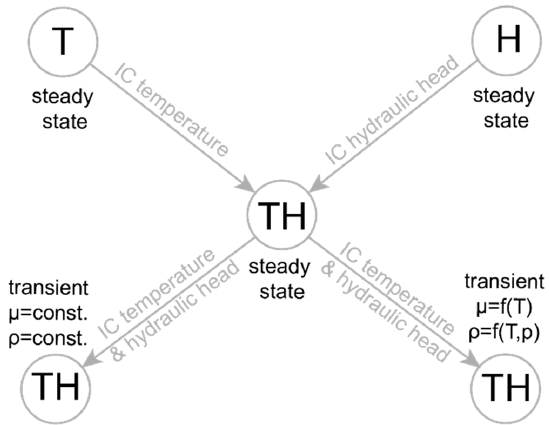
Figure 3. Hydraulic and thermal processes are tested successively with different orders of complexity. Beginning with uncoupled steady-state settings coming to fully coupled transient conditions. Arrows indicate initial conditions (IC) for the next scenario.